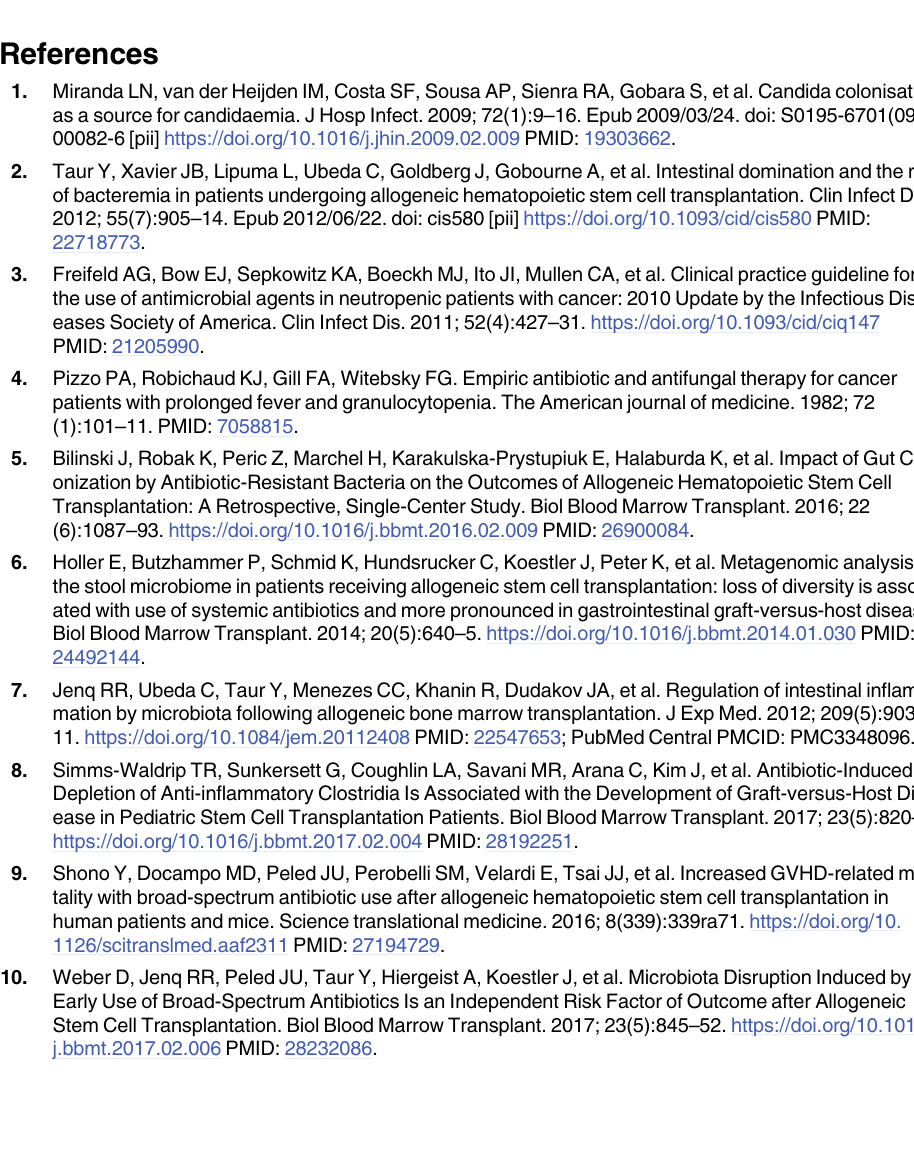
Fig 2. Schema of potential novel approaches to reducing bacterial and fungal infections in cancer and stem cell transplant (SCT) patients. FMT, fecal microbiotatransplantation; GI, gastrointestinal.